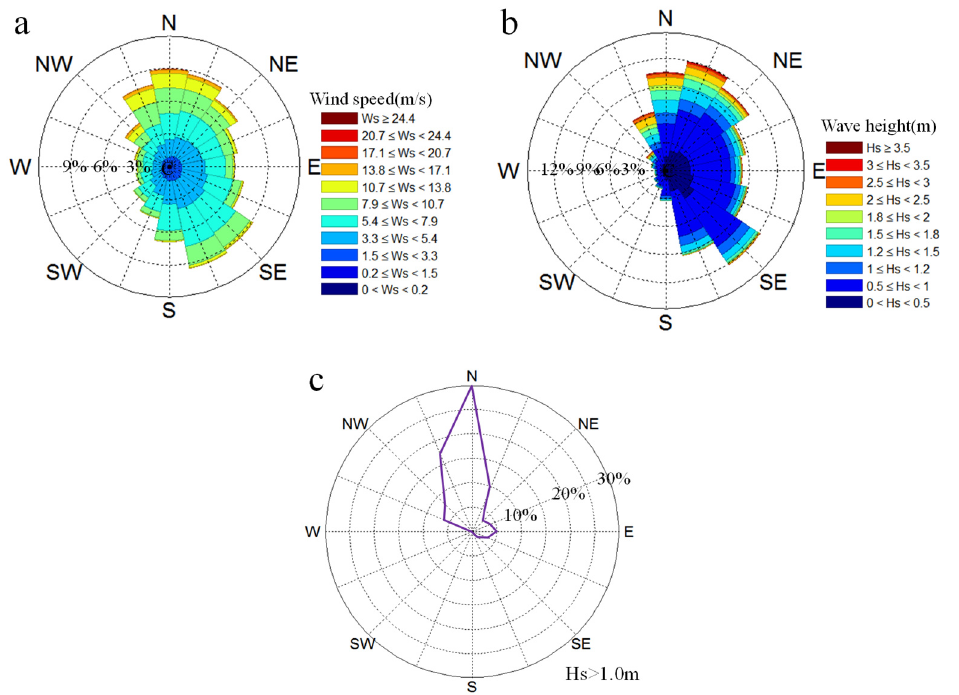
Figure 8. The deep-water wind rose diagram ( a ) and wave rose diagram ( b ). Data for ( c ) is extracted from [31].